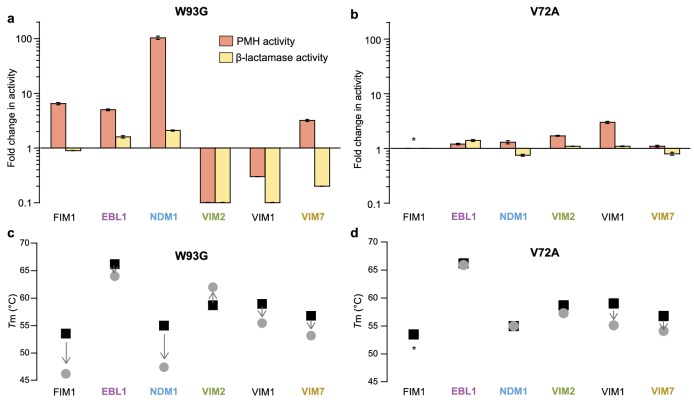
Differential effects of mutations (W93G and V72A) on six metallo-β-lactamases.Fold change in PMH and β-lactamase activity of variants. (A) W93G and (B) V72A variants compared to the variants containing a Trp93 and Val72. Activity levels of purified enzymes were measured at single enzyme (5 μM for PMH and 1 nM for β-lactamase activity) and substrate (500 μM for PMH and 100 μM for β-lactamase activity) concentrations. The wild-type NDM1 contains an Ala at position 72; the activity presented is the ratio of the wild-type to the A72V variant. The wild-type EBL1 contains a Pro at position 72; the activity presented is the ratio of the P72A to the P72V variant. Errors bars represent the standard deviation calculated from three measurements. Changes in melting temperature (Tm) of (C) W93G and (D) V72A. Black squares denote the wild-type enzyme, and grey circles denote the mutant. Arrows indicate the change of melting temperature by the mutation. The melting temperature was calculated from the midpoint of the thermal denaturation curve of purified proteins. Asterisks indicate that the fold change in activity and change in Tm could not be determined, because one of the variants was not soluble. The catalytic activities and Tm of each mutant are listed in Supplementary file 1H.